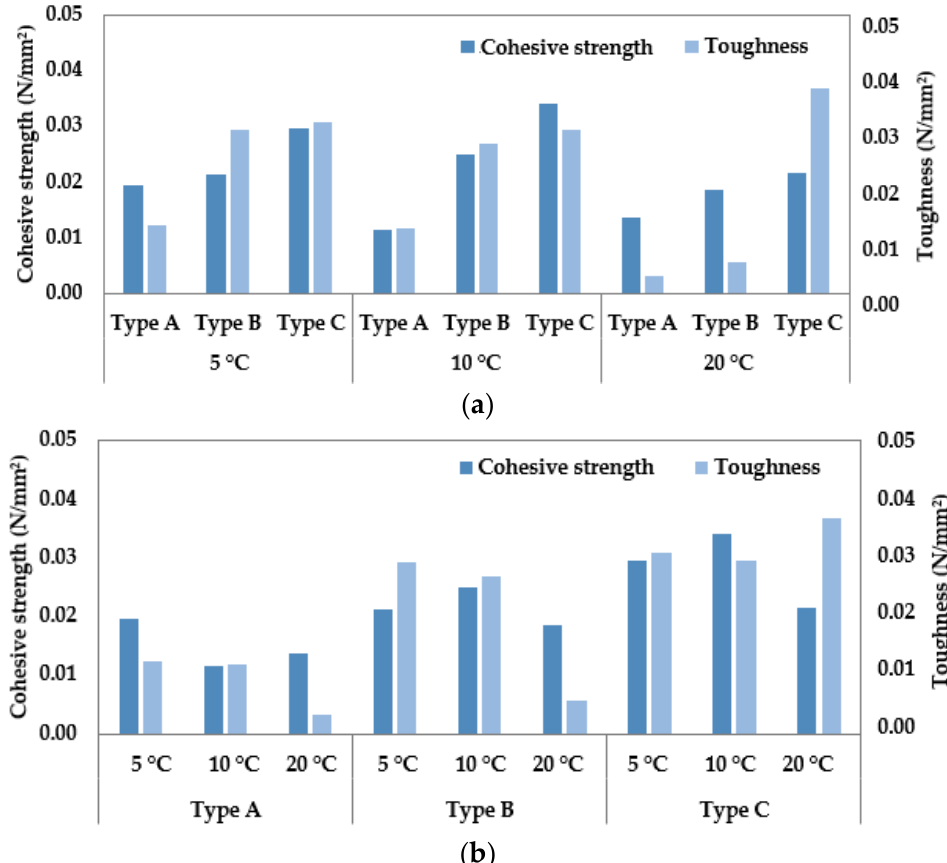
Figure 7. Cohesive strength and toughness comparison of viscosity types based on temperature condition (2 mm thickness); ( a ) toughness and cohesion strength comparison based on viscosity type, ( b ) toughness and cohesion strength comparison based on temperature condition.